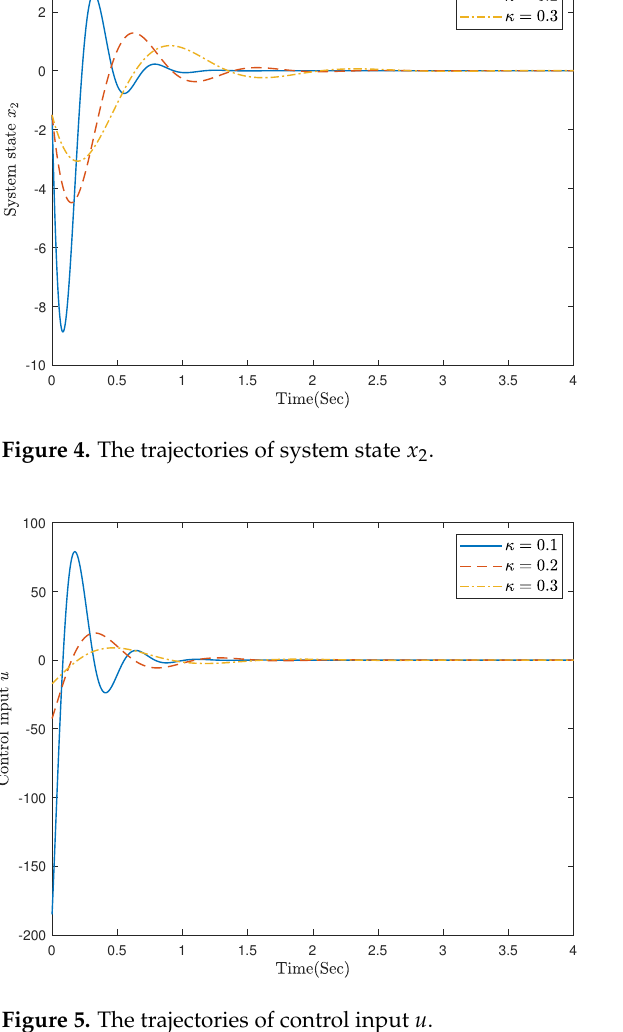
Figure 5. The trajectories of control input u